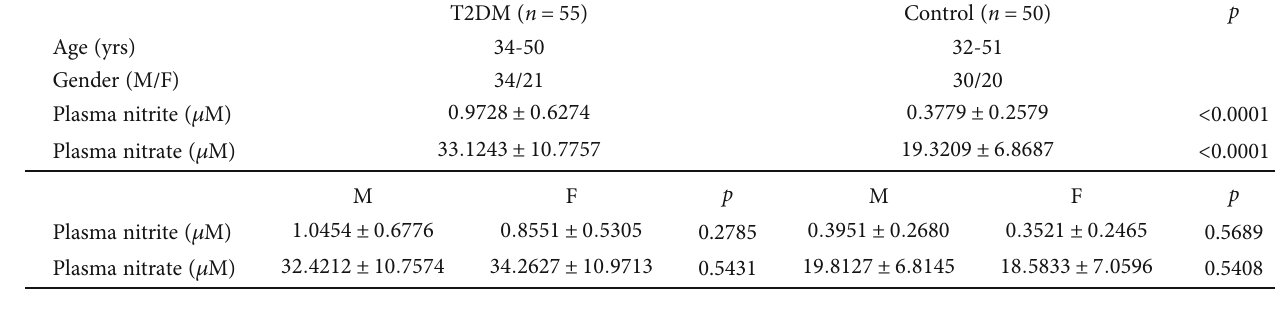
Table 1: Clinical data in the T2DM group and control group.